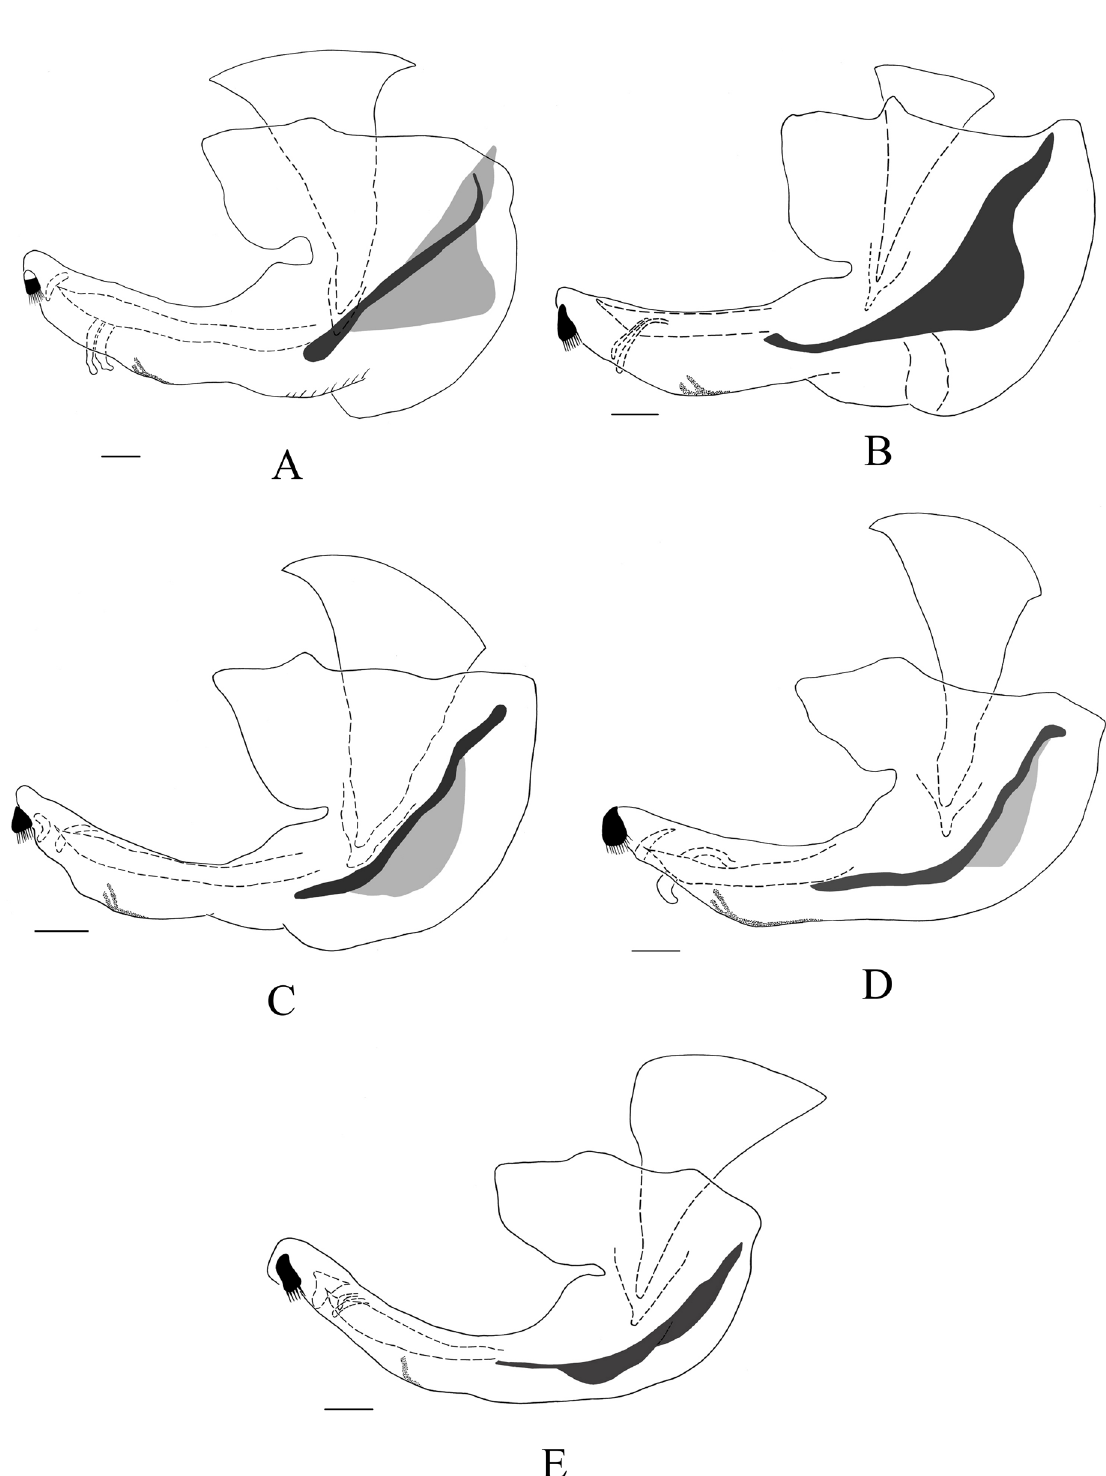
Fig. 23. Hypandrium, lateral view. A . Eumerus hissaricus Stackelberg, 1949, Ghoochan, Iran (HMIM). B . E. kazanovzkyae Paramonov, 1927, Paveh, Iran (HMIM). C . E. pilosipedes Gilasian & van Steenis sp. nov., holotype (HMIM). D . E. vallicolus Gilasian & van Steenis sp. nov., holotype (HMIM). E . Eumerus sp., Khash, Iran (HMIM). Scale bars = 0.1